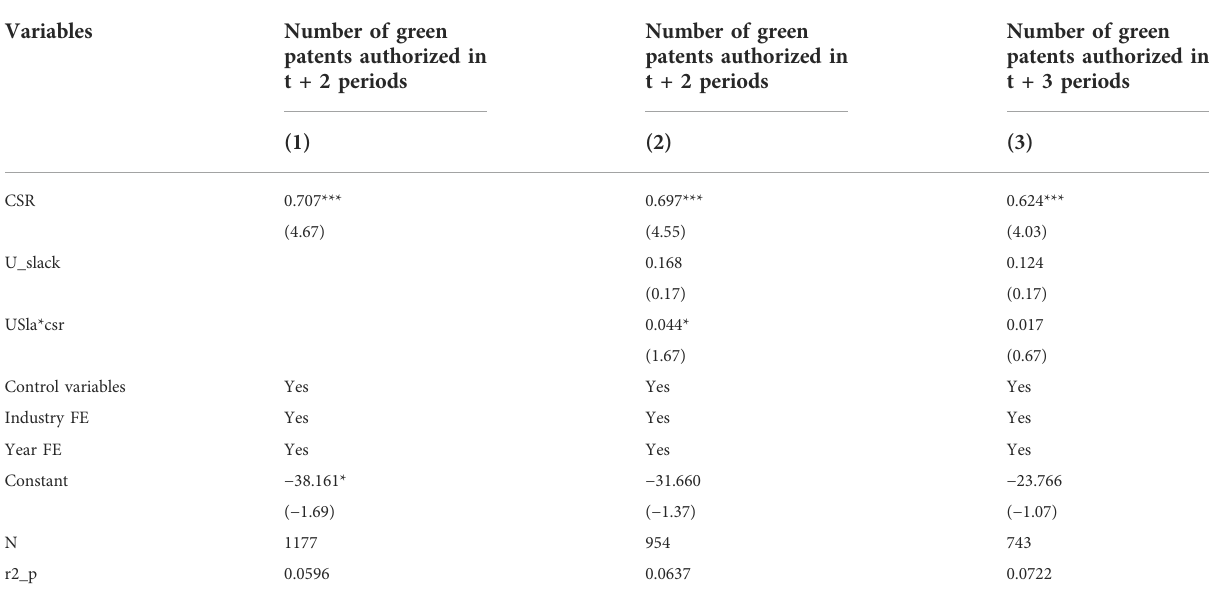
TABLE 9 Additionally lagged green patents